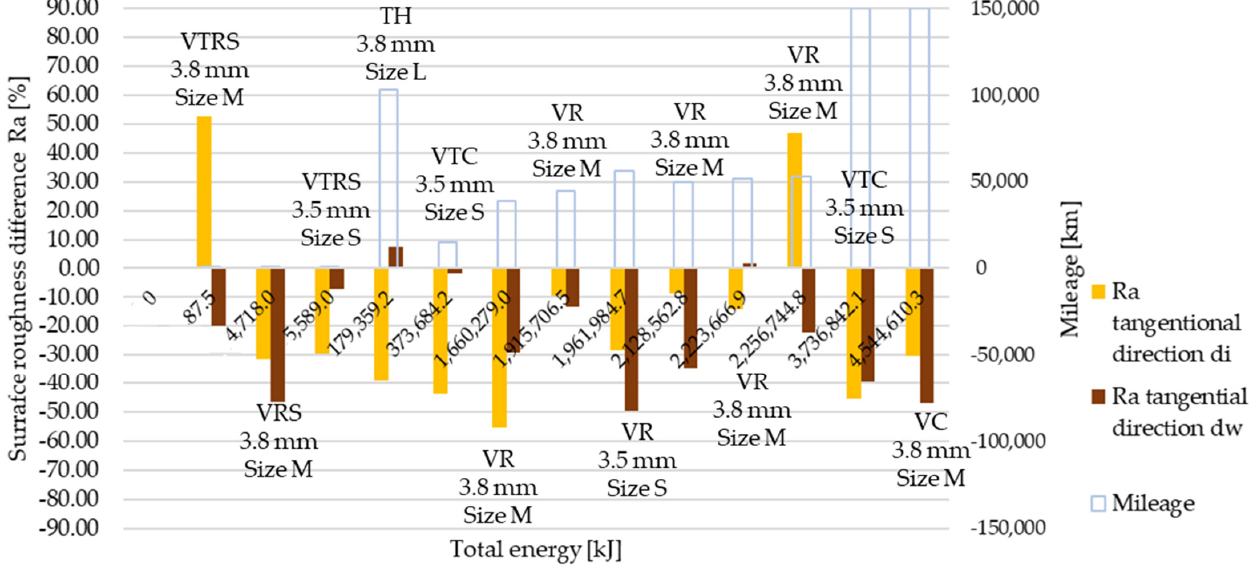
Figure 13. Deviation of Ra surface roughness values from initial conditions, tangential direction.